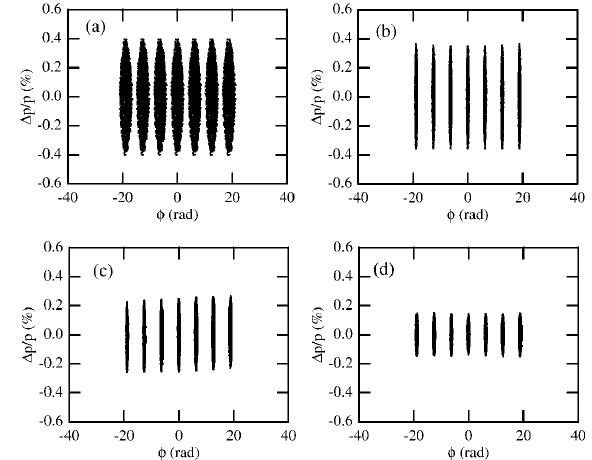
FIG. 12. Phase-space projection of the rf-bunch beam at (a) injection, (b) 4.69 GeV, (c) 6.69 GeV, and (d) 11.64 GeV. k is set to (cid:5) 2 : 00 (cid:1) kV =(cid:22) s (cid:2) .